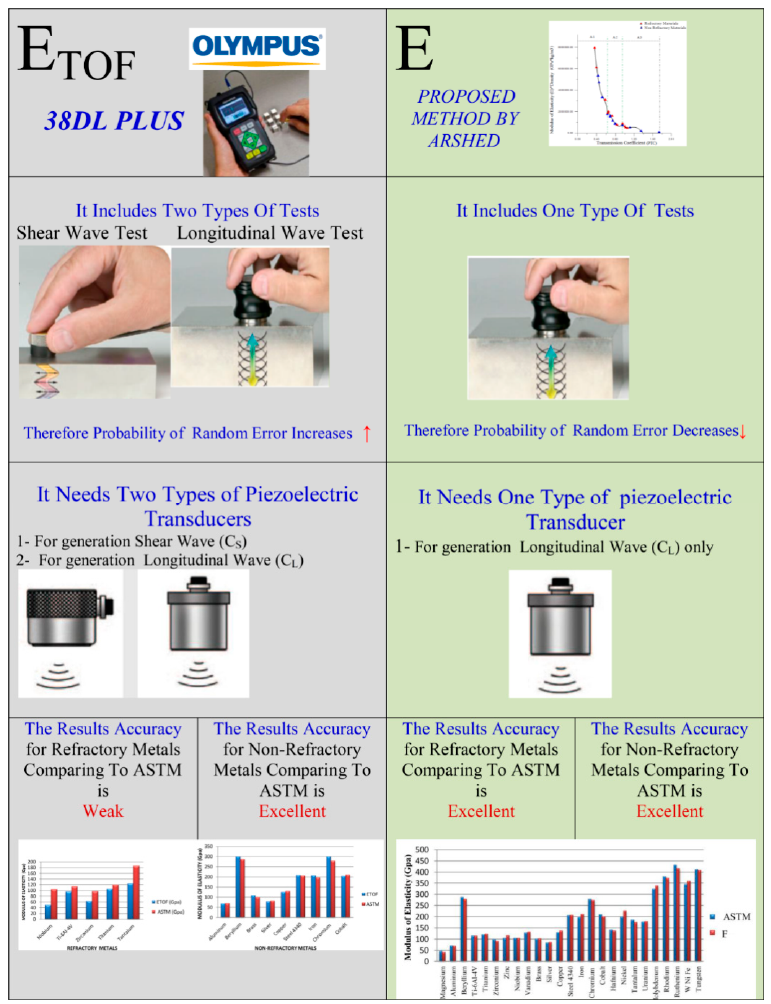
Figure 10. Comparison between time-of-flight (TOF) method and Arshed method.